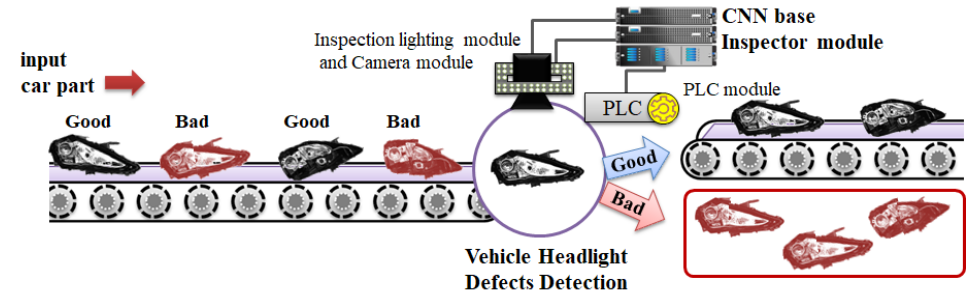
Figure 2. CNN-based vehicle headlight defects of the detection system structure.